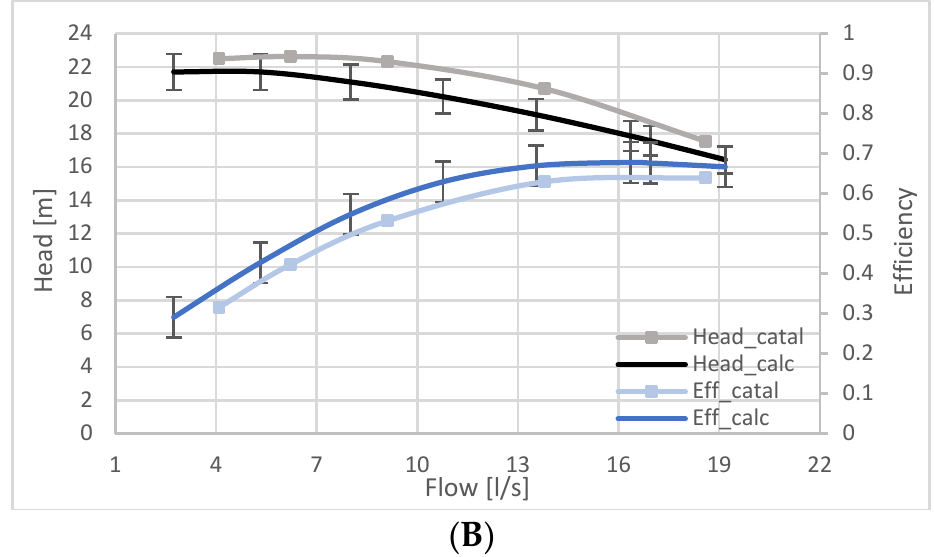
Figure 14. ( A ) Head and efficiency for the PAT 65-250 (ns = 22.75) in pump operation. ( B ) Head and efficiency for the PAT 65-250 (ns = 22.75) in pump operation with z = 6, b = 0.038 m, b5 = 0.054 m, and cl = 3.5 × 10 − 4 m.